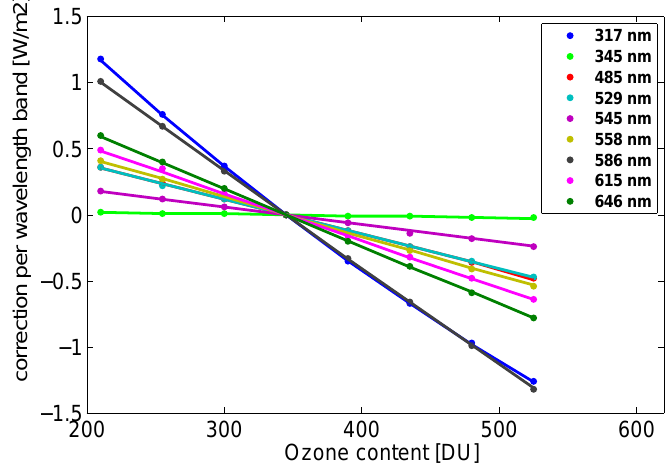
Figure 4. Differences between I H 2 O,O 3 (dots) and by use of the correction formula (lines, Equation (5)) for nine Kato wavelength bands and the solar zenith angle of 20 ◦